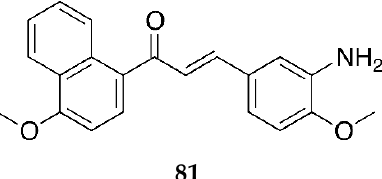
Figure41. Chemicalstructuresof3 (cid:48) -aminochalconederivativeswithhydroxyandmethoxysubstitutions Figure 41. Chemical structures of 3′-aminochalcone derivatives with hydroxy and methoxy on ring A and ring B. substitutions on ring A and ring B.